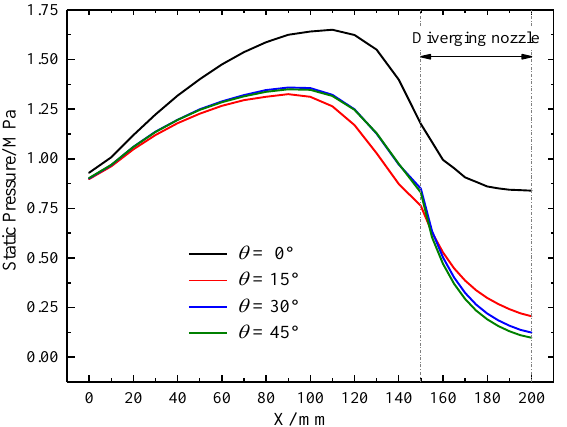
Figure 13. The averaged static pressure in different axial cross-sections of the RDC at t = 3980 μs.